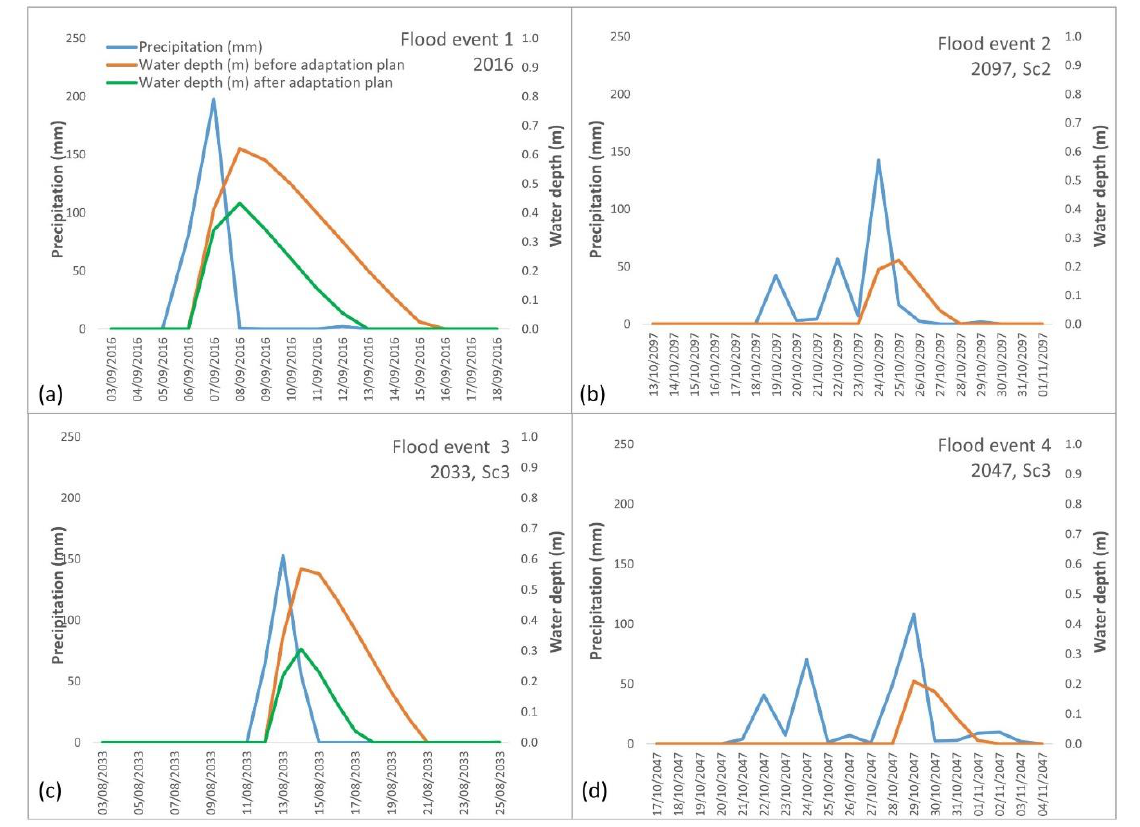
Figure 5. Results of the flood modeling. Precipitation vs. maximum water depth, before and after the flood adaptation plan, at the Agora site (maximum water depth site; see Figure 2); ( a ) of the 6–8 September 2016 flood event; ( b ) of the Sc2 19–24 October 2097 flood event; ( c ) of the Sc3 12–14